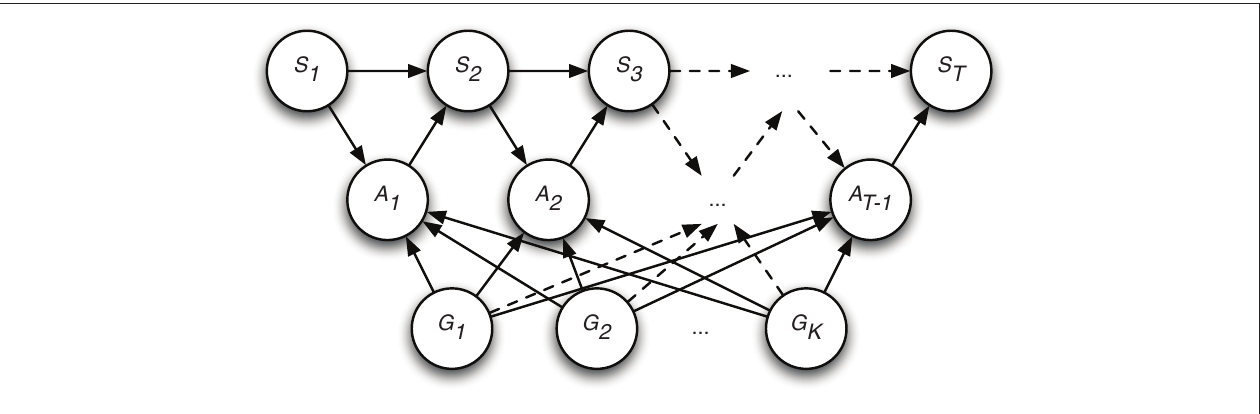
Figure 2 | The BiP-Bayesian network with T time slices: S The goal variables,